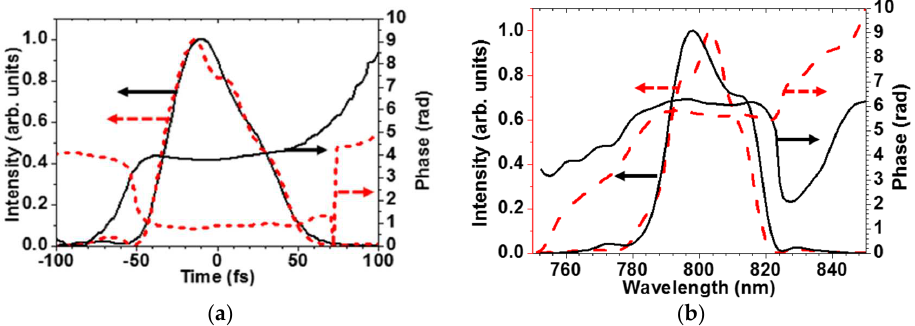
Figure 4. ( a ) Temporal intensity and phase profiles of the reference pulse (800 nm) retrieved from SHG FROG (broken line) and SD FROG (solid line) traces; ( b ) Spectral intensity and phase profiles of the reference pulse.